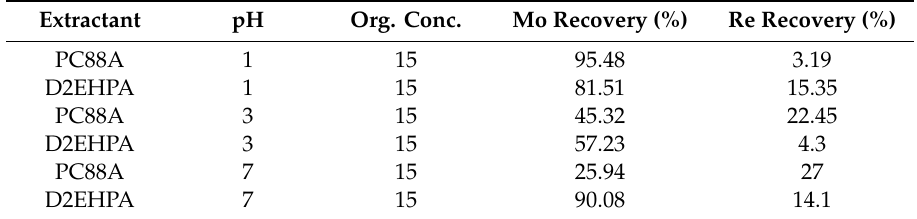
Table 4. Comparison of PC88A and D2EHPA capability of separation between Re and Mo.